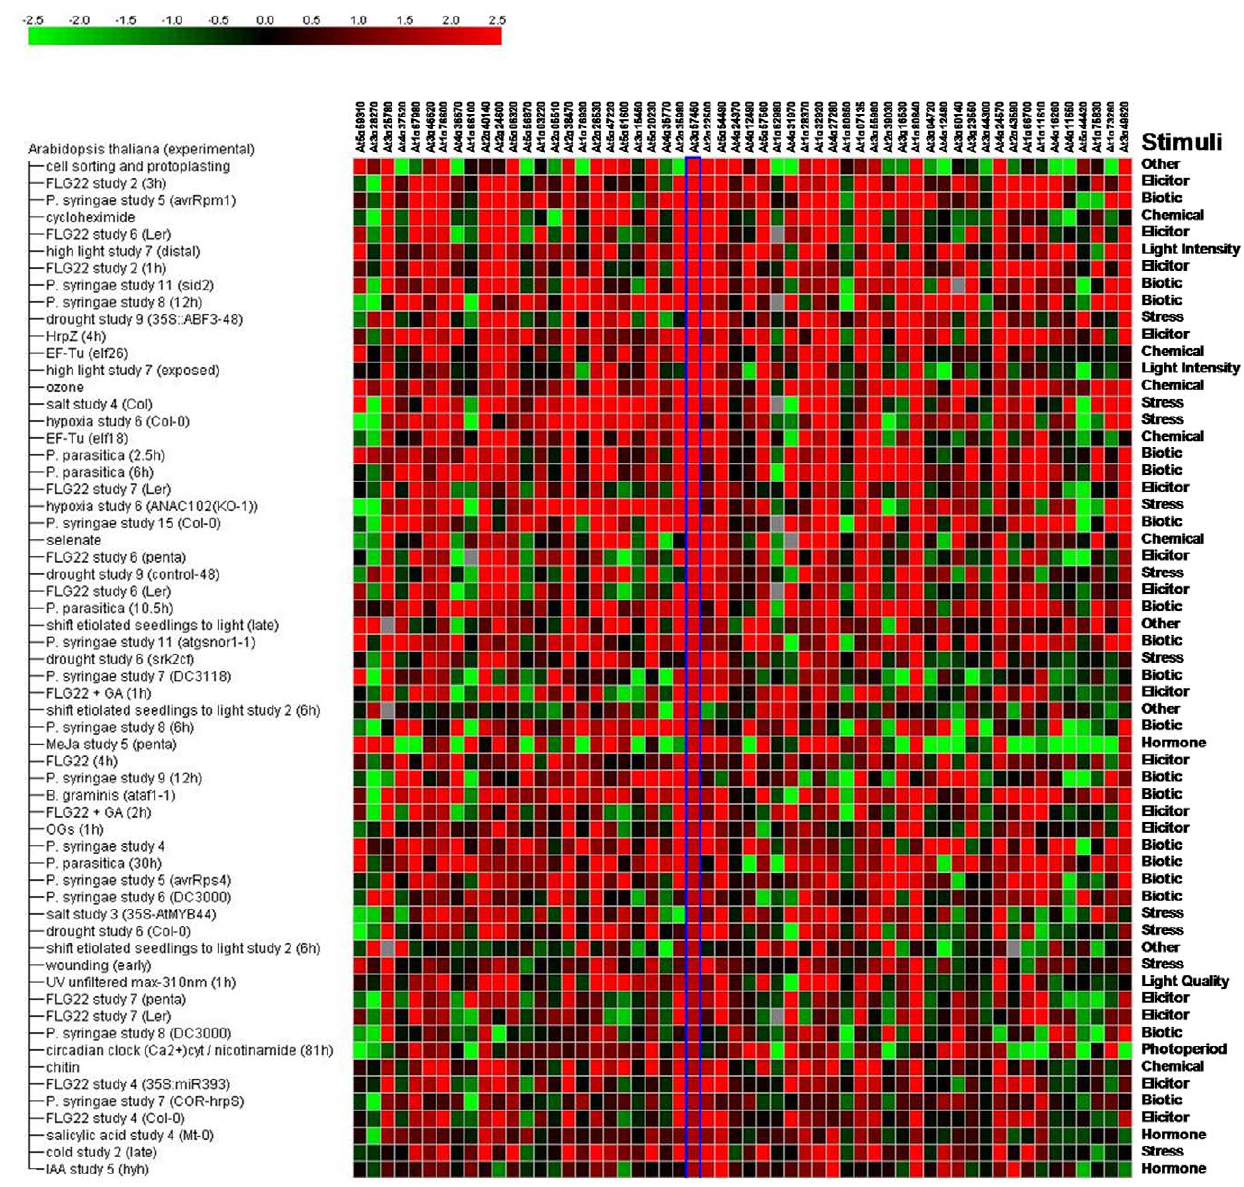
Figure 5. Comparison between genes modulated in the presence of earthworms with other transcriptomic studies. Among our 59 genes, 56 upregulated genes were found in Genvestigator database (in column). We then select a list of 60 studies (in line), among 54 922 referenced in Genevestigator, exhibiting the most similar directional changes with the 56 genes of our study by choosing the ‘‘mosaic’’ with the highest number of red squares (higher transcript abundance in the treatment as compared with control). Green color is corresponding to a lower transcript abundance for the treatment as compared with the control, and red color is corresponding to higher transcript abundance. Color intensity is corresponding to the fold change in gene transcript abundance.